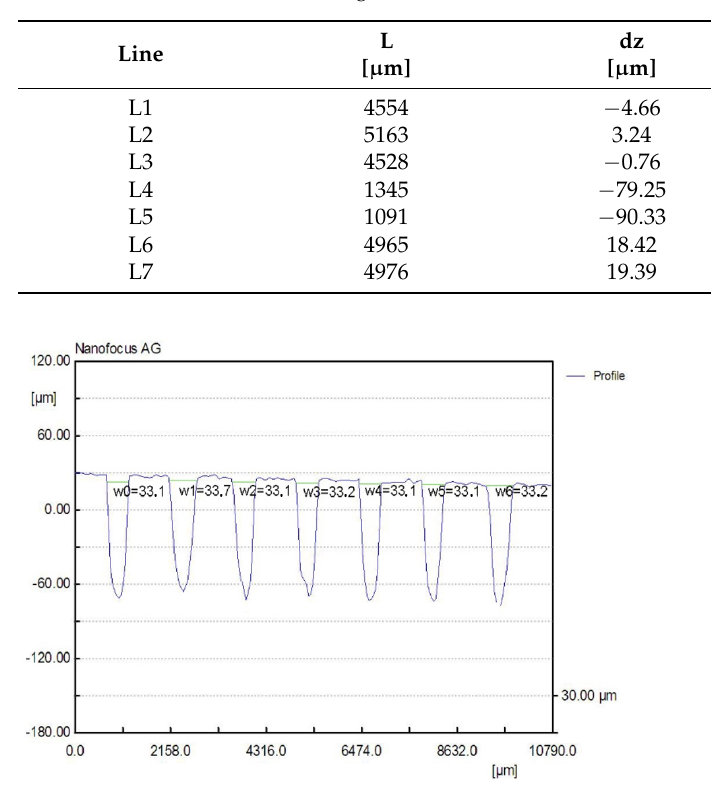
Table 2. Dimensions of the convergent nozzle.